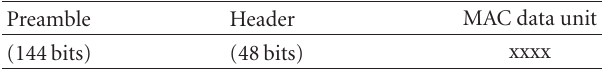
Table 5: Physical layer data